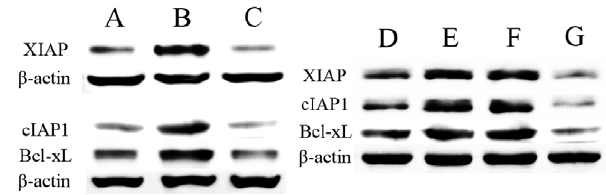
Figure 5. Effects of different treatments on NF- k B regulated anti-apoptotic factors. KTC-1 cells were left untreated as controls ( A ), or treated with 20 MBq/ml 131 I ( B ) or in combination with 5 m mol/L Bay 11-7082 ( C ) for 24 hours. Then whole cell lysates were examined by Western blot for XIAP, cIAP1 and Bcl-xL. In the second set of experiments, control cells were left untreated ( D ). After no oligonucle- otide ( E ), scrambled oligonucleotides ( F ) or p65 siRNA ( G ) transfection, KTC-1 cells were treated with 131 I (20 MBq/ml) for 24 hours. Then protein levels of XIAP, cIAP1 and Bcl-xL were studied. b -actin was used as a loading control. Similar results were obtained in three independent experiments.